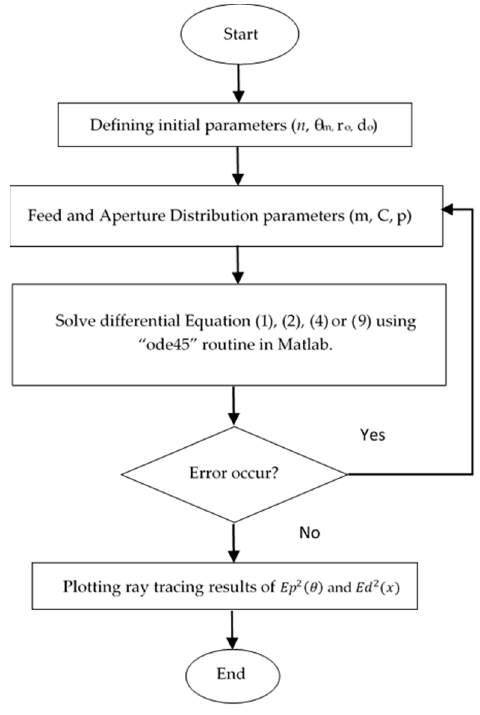
Figure 4 . MATLAB Program .